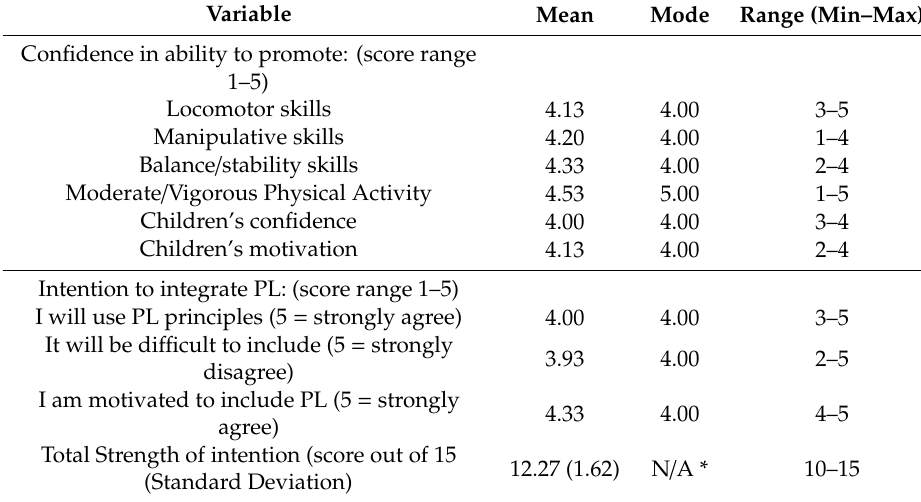
Table 5. Post JEPD teacher confidence in their ability and intentions to promote key PL concepts.